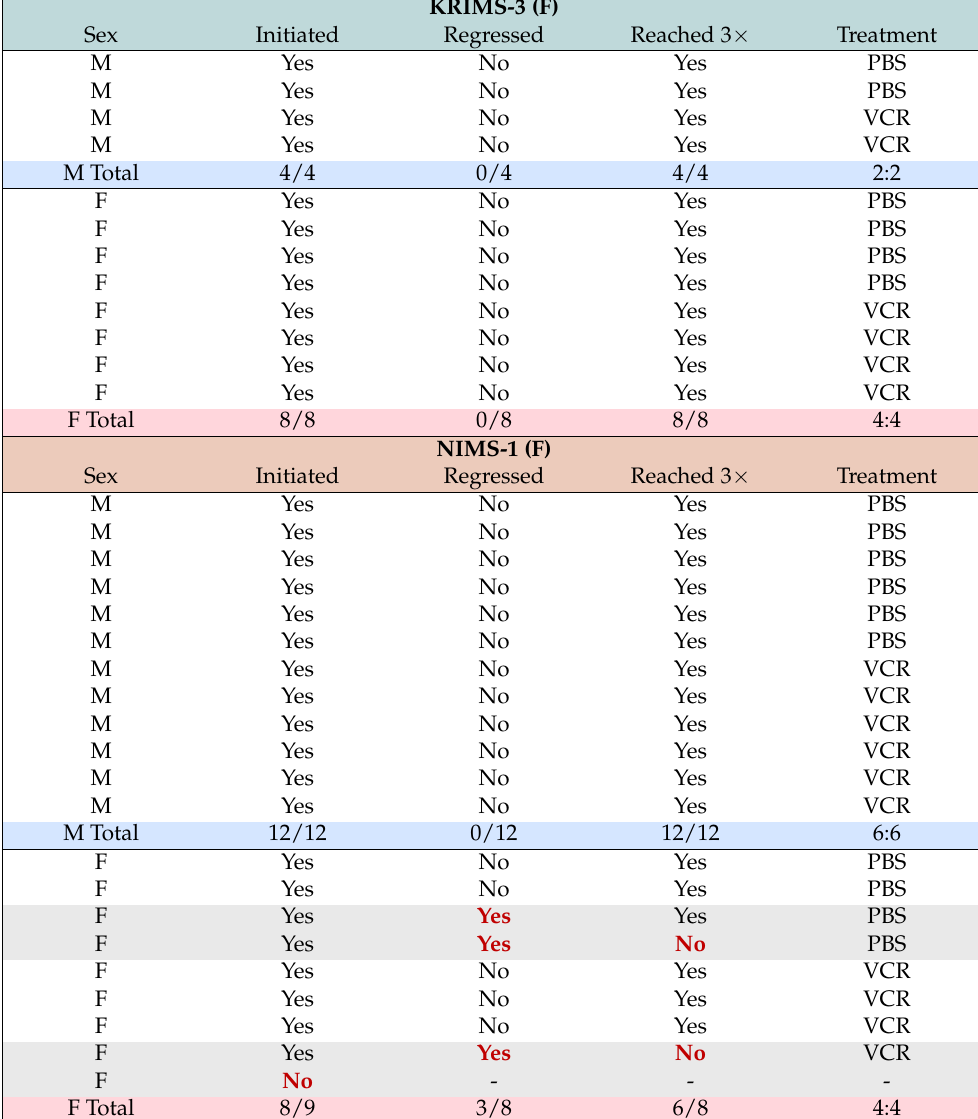
Table 1. KRIMS and NIMS allograft development, growth, and